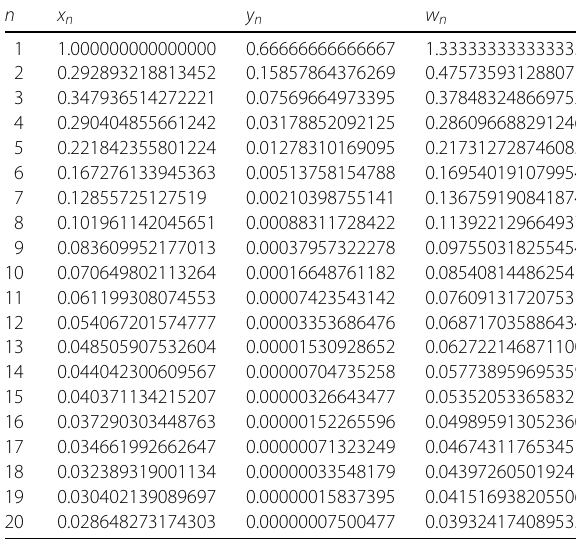
Table 3 Numerical results of { x n } , { y n } , and { w n } with initial x 1 = 1.0 based on